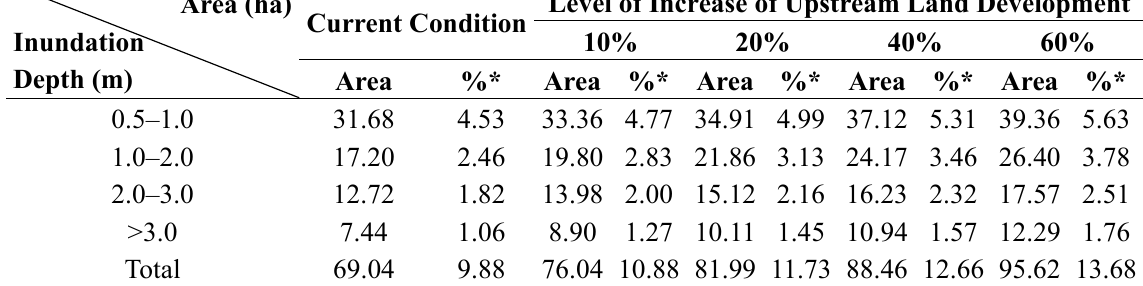
Table 5. Effects of different levels of upstream development on the Percentage of the Inundation Area of the Urban Planning Zone (25-year Return Period).